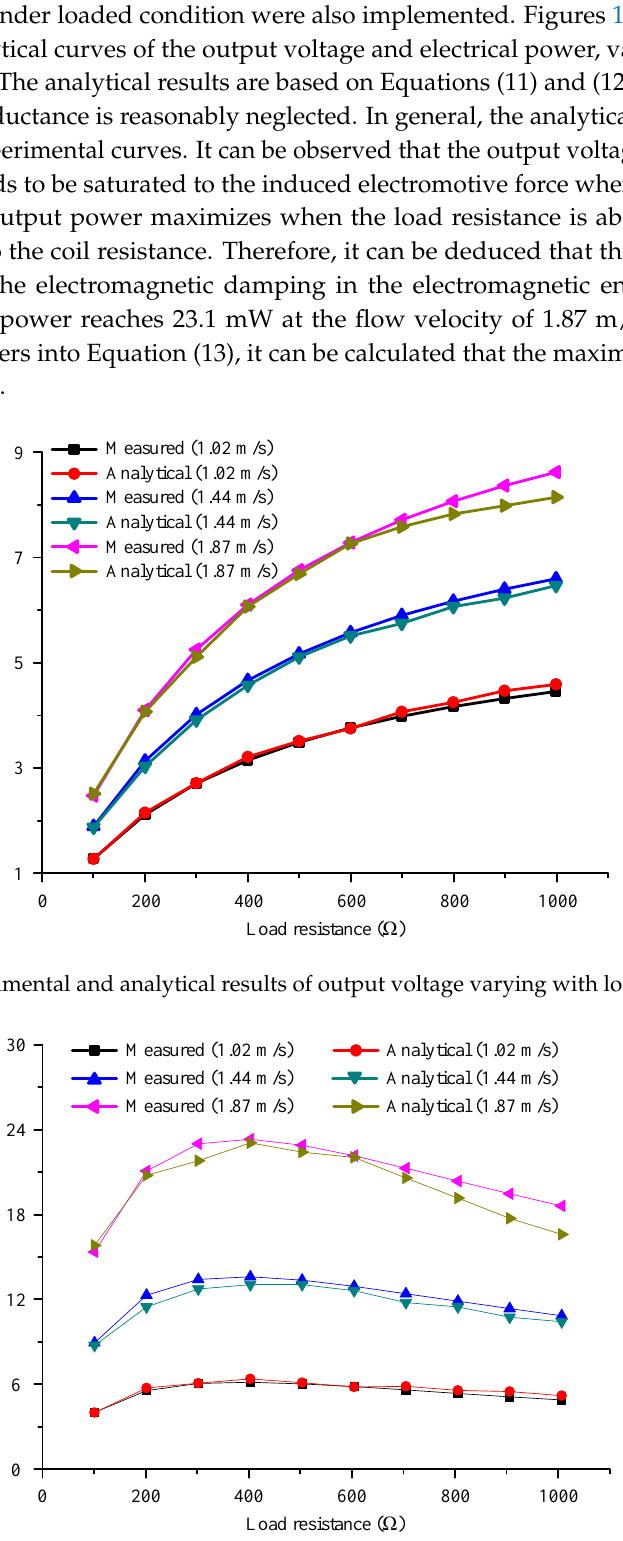
Figure 13. Experimental and analytical results of output electrical power varying with load resistance.